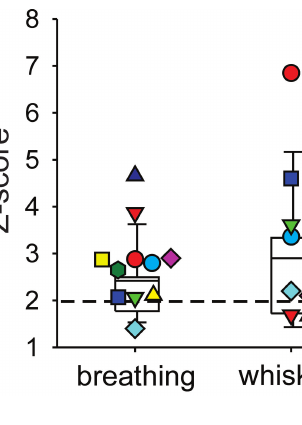
FIGURE 5 | Summary of behavior-spike cross-correlation results expressed as Z -scores of peak correlation values for breathing, whisking, and licking behavior (left, middle, and right column, respectively). Each symbol represents one mDCN unit’s Z -score for each behavior. Only Z -scores > 1 are shown. Spike activity of all 11 units was significantly correlated ( Z -scores > 2, dashed horizontal line) with either breathing or whisking. Activity of five units was correlated with respiration alone, one unit’s activity was correlated with whisking alone, and the remaining five units had spike activity correlated with both breathing and whisking. One unit (red circle) had spike activity significantly correlated with all three behaviors. Box and whisker plots show median, 25th and 75th percentile (box) and 9th and 91st percentile